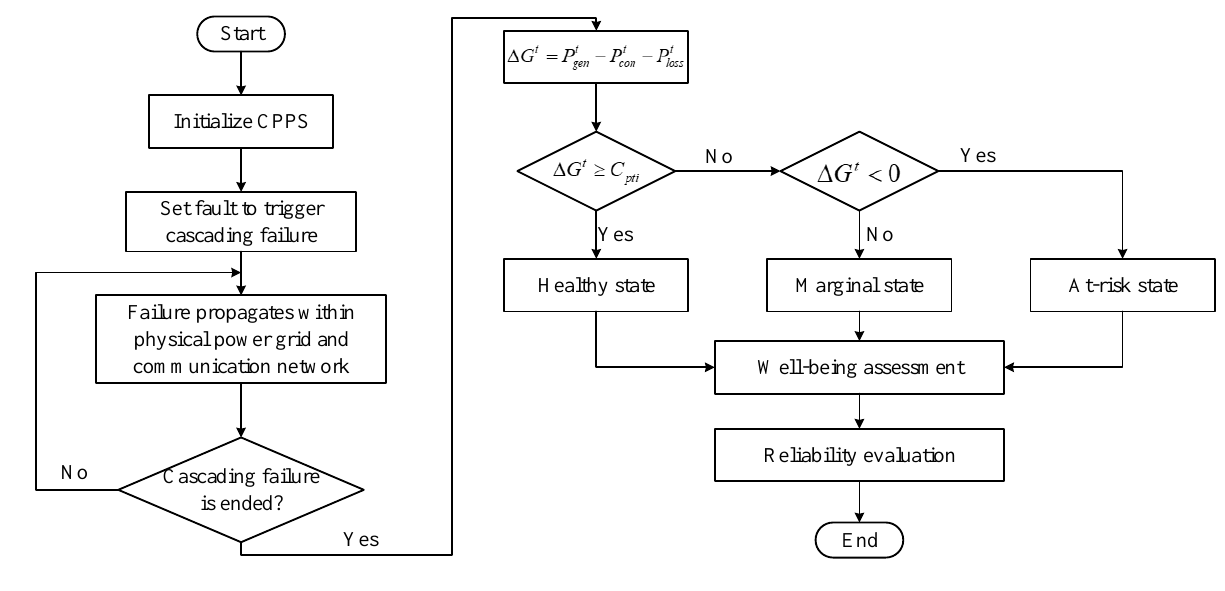
Figure 2. The flowchart of the well-being assessment and reliability evaluation.